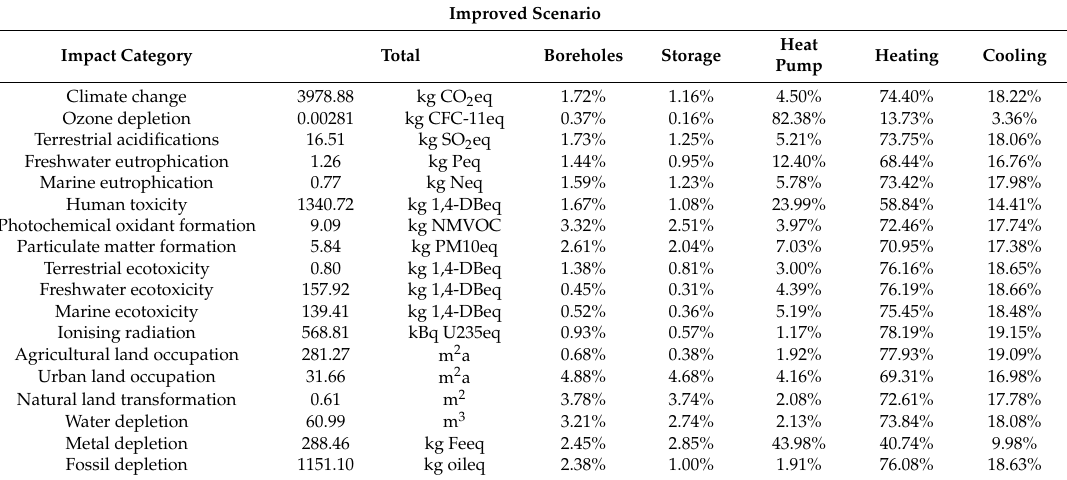
Table 6. Midpoint impact indicators for the improved scenario.